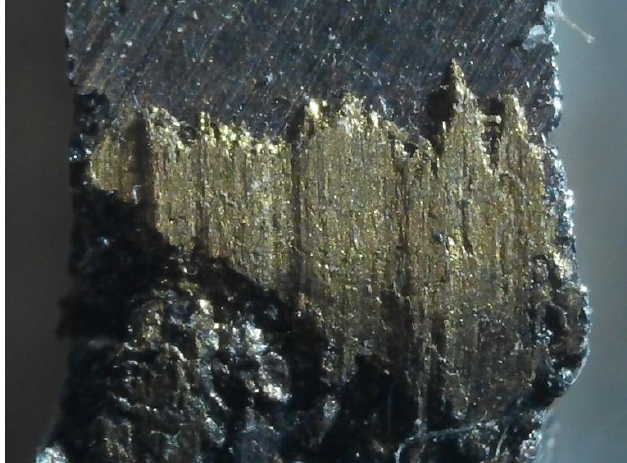
Fig. 11. The sticking of brass L63 on the rear surface of the cutter made of cast iron SCh20 when rubbing